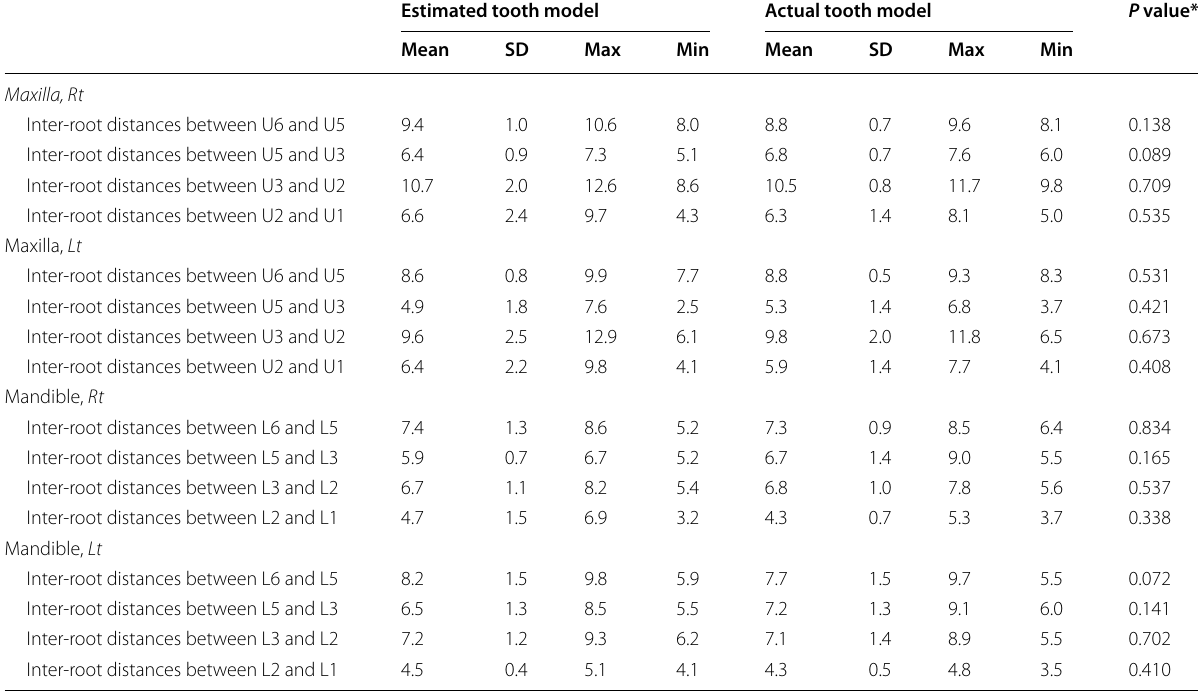
SD, Standard deviation *The results of paired t test. U6, maxillary first molar; U5, maxillary second premolar; U3, maxillary canine; U2, maxillary lateral incisor; U1, maxillary central incisor. L6, mandibular first molar; L5, mandibular second premolar; L3, mandibular canine; L2, mandibular lateral incisor; L1, mandibular central